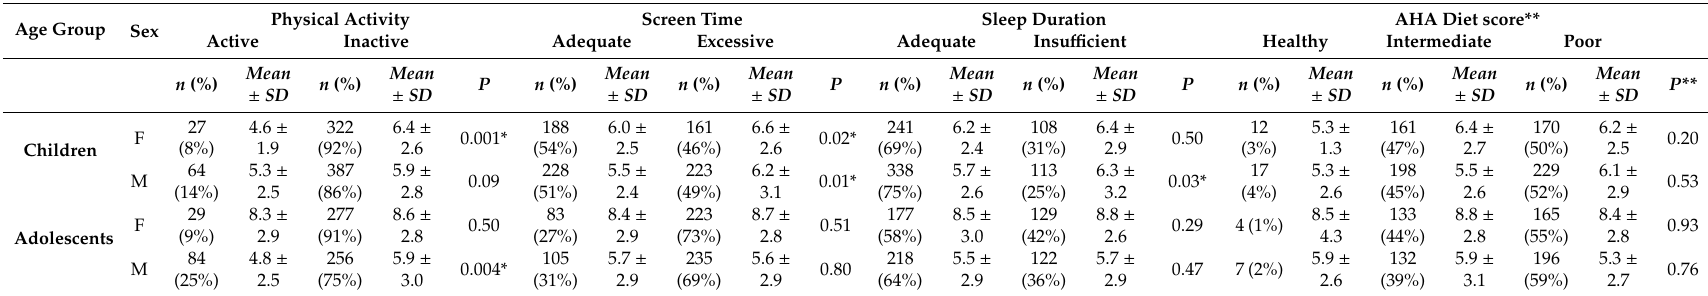
Table 3. Means and standard deviation of fat mass index (FMI) (kg / m2) according to presence or absence of each OL component in Mexican children and adolescents. Age Group Sex